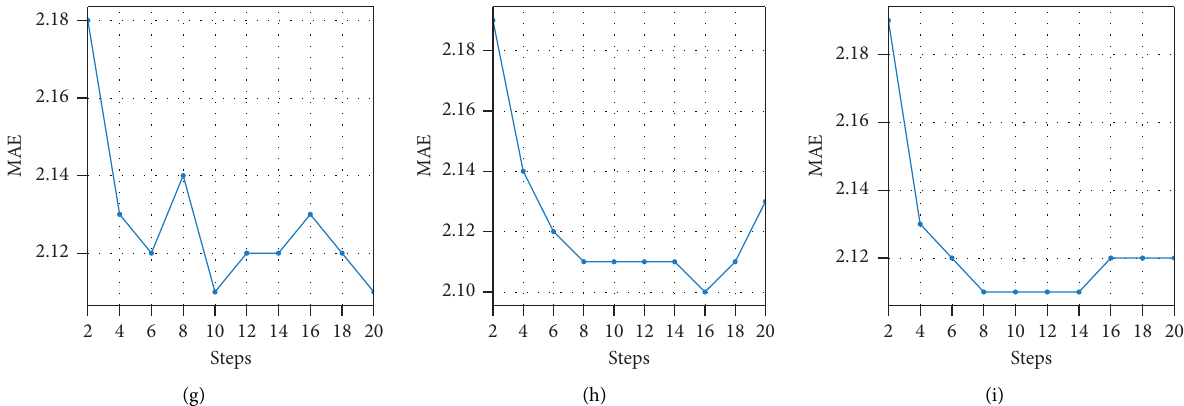
Figure 6: Prediction errors of frequently used models with different backtracking steps on detector 16,885. (a) DT. (b) SVM. (c) KNN. (d) RF. (e) GBDT. (f) SAE. (g) LSTM. (h) GRU. (i)